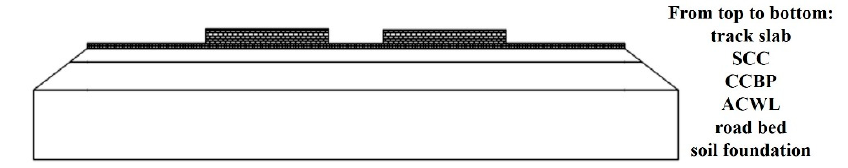
Figure 5. Model of ballastless track structure.